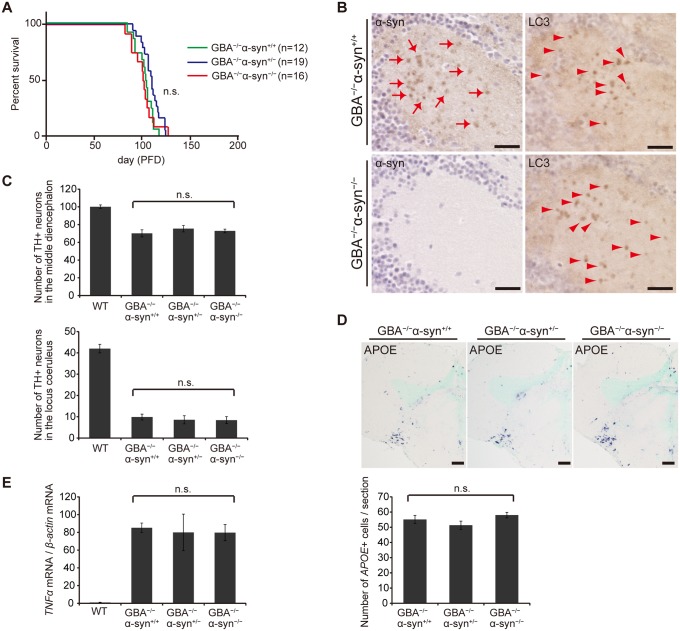
Disruption of α-syn did not change the pathological phenotypes in GBA
-/- medaka.(A) Survival curves for each genotype. Life spans were not changed among genotypes. (B) α-syn and LC3 immunohistochemistry in the diencephalon. α-syn accumulations were observed only in GBA
-/-
α-syn
+/+ medaka (arrows). The number of LC3-positive puncta was not different between GBA
-/-
α-syn
+/+ and GBA
-/-
α-syn
-/- medaka (arrowheads). Scale bars, 20 μm. (C) Number of TH-positive neurons in the middle diencephalon and the locus coeruleus at 3 months (n = 6). (D) Upper panel: APOE in situ hybridization in the optic tectum and the diencephalon. Lower panel: The number of APOE-positive cells per section (n = 9). Scale bars, 50 μm. (E) Quantification of TNFα mRNA levels normalized to β-actin mRNA in medaka brains with quantitative RT-PCR (n = 8). For all analyses, data are the mean ± SEM.